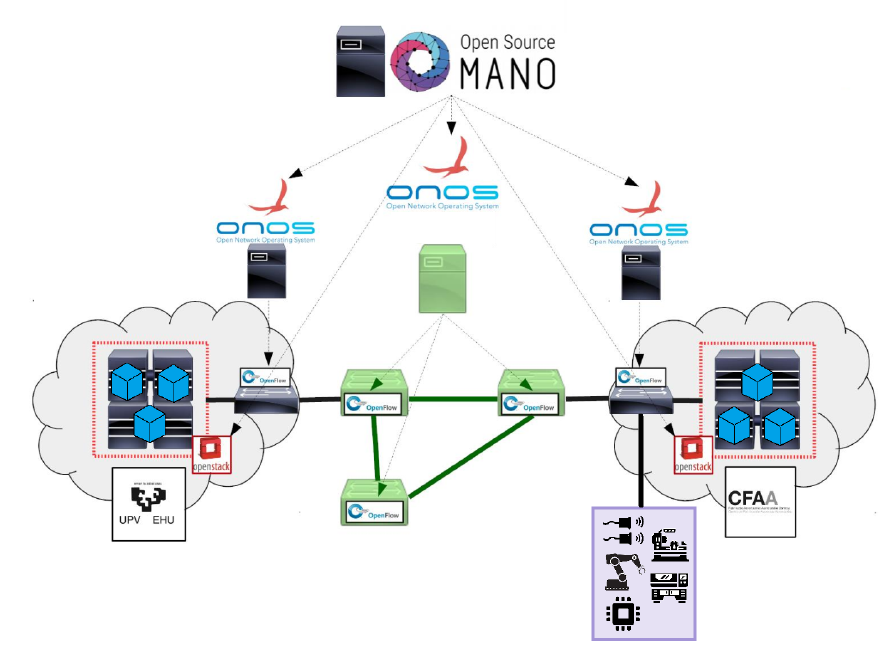
Figure 6. Proposed Architecture.